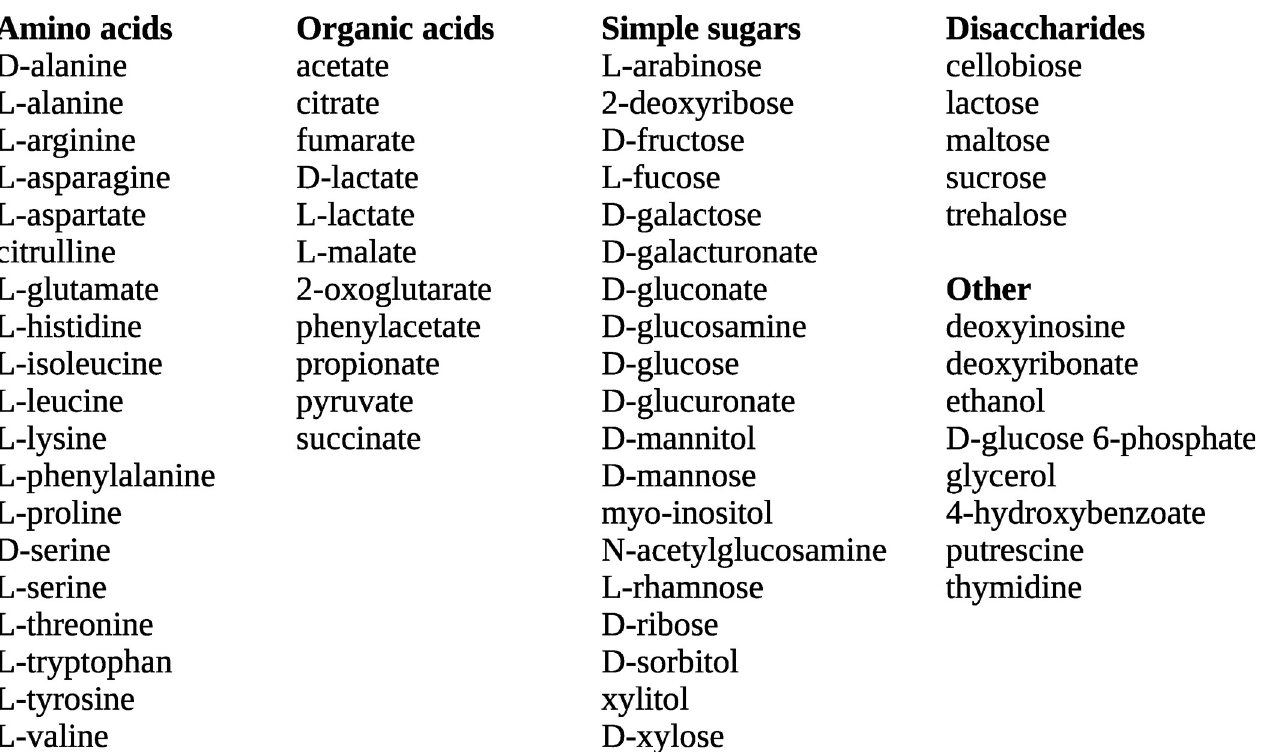
Fig 1. The 62 carbon sources described in